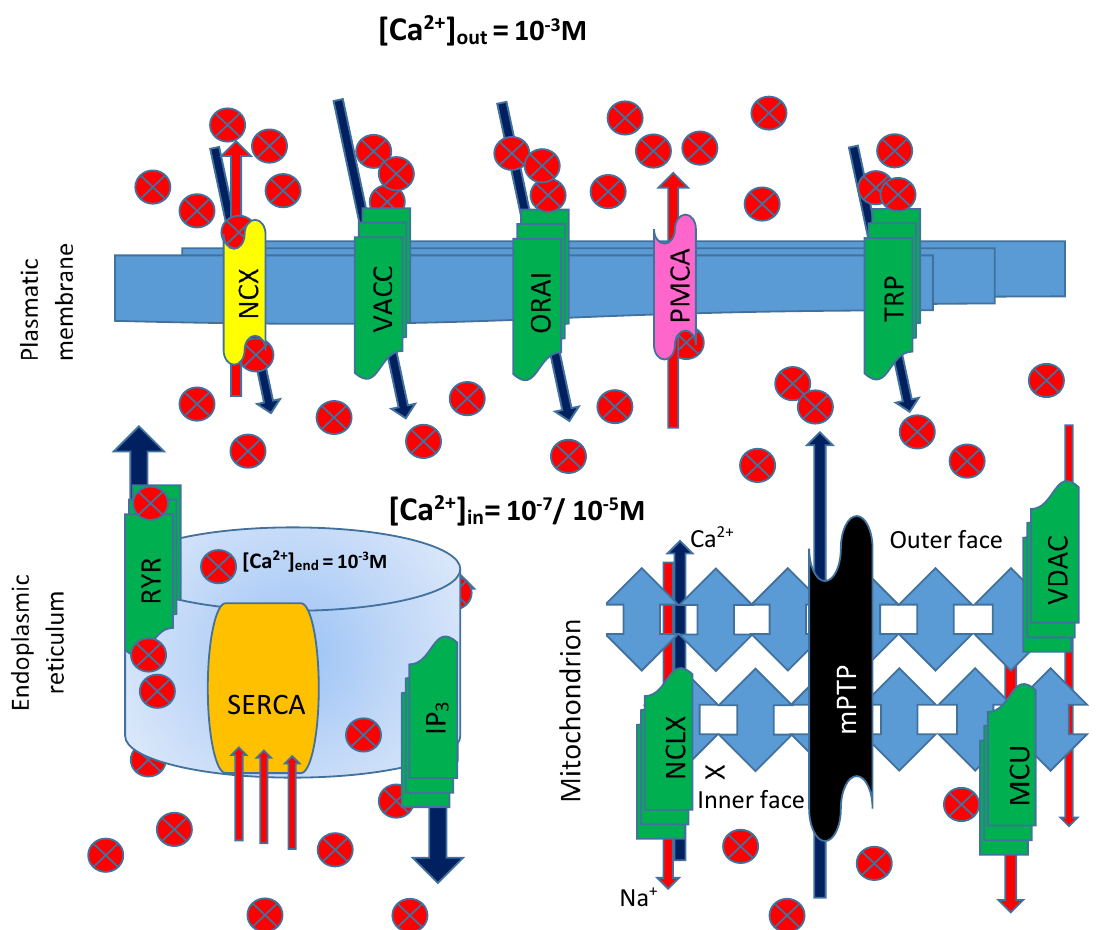
Figure 3. Calcium Signaling. Ca 2+ ions enter into the cell through transient receptor potential (TRP) channels, voltage-activated Ca 2+ channels (VACC), store-operated Ca 2+ entry (ORAI) channels, or through modulator of Ca 2+ homeostasis (NCX). The Na + /Ca 2+ exchanger and the pump located on the plasma membrane (ATPase PMCA) extrude Ca 2+ into the extracellular space from the cytosol. Inside the cell, another pump, the sarco/endoplasmic reticulum ATPase (SERCA), pumps Ca 2+ into the lumen of the endoplasmic reticulum, from where it is released through IP 3 -receptor and Ryanodine-sensitive (RYR) channels. Mitochondrial Ca 2+ uptake occurs through the voltage-dependent anion channel (VDAC) in the outer mitochondrial membrane and the mitochondrial Ca 2+ uniporter complex, known as the MCU. Ca 2+ is extruded under the control of the Na + /Ca 2+ exchanger, encoded by the NCLX gene, and H + /Ca 2+ antiporter. Ca 2+ accumulation within the mitochondrial matrix provokes the formation of the mitochondrial permeability transition pore (mPTP), resulting in an uncontrolled release of Ca 2+ , apoptotic factors (AF), and reactive oxygen species (ROS). The mitochondria were the first intracellular organelles associated with Ca 2+